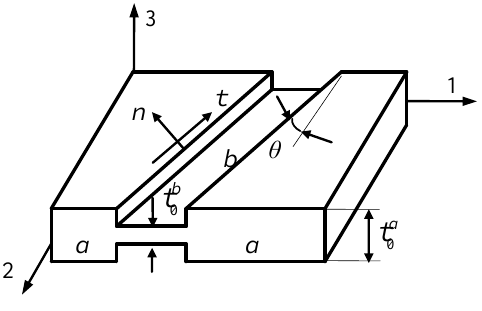
Figure 2. Geometric model of M – K theory.